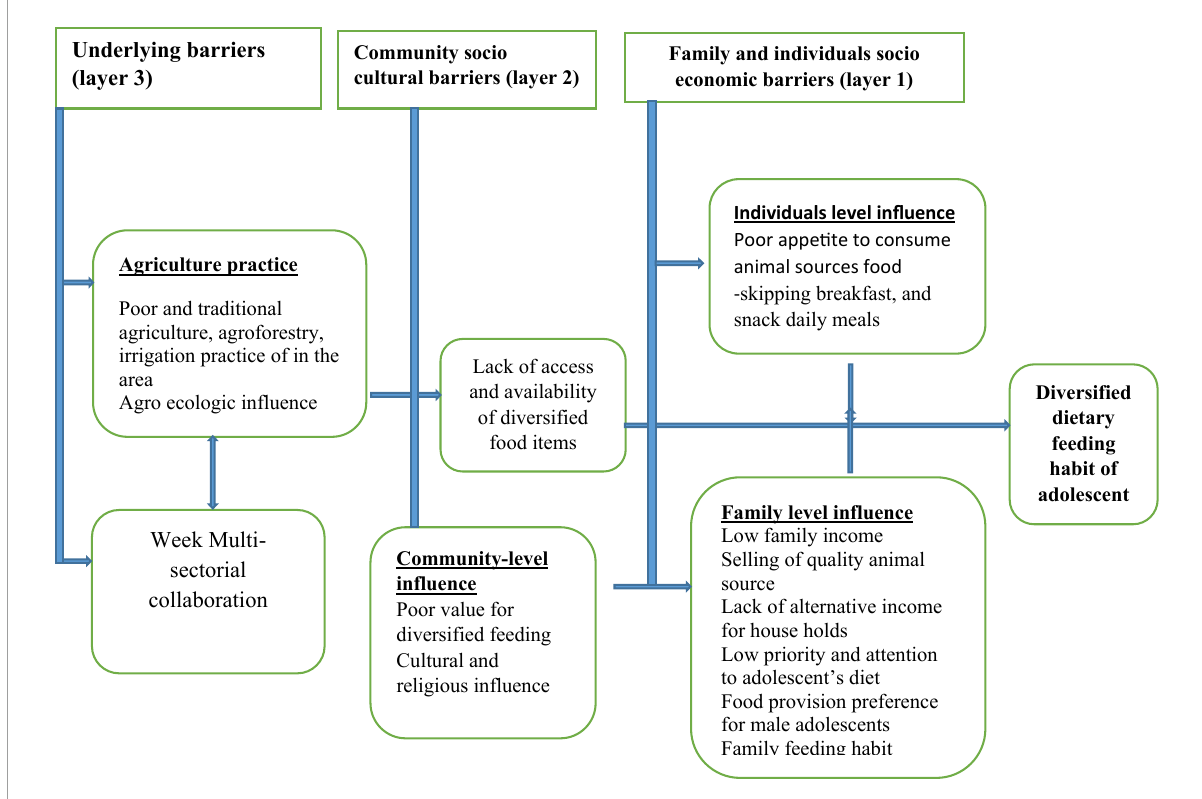
FIGURE1 Conceptual framework of barriers for diversified dietary feeding habit of adolescents, 2021.